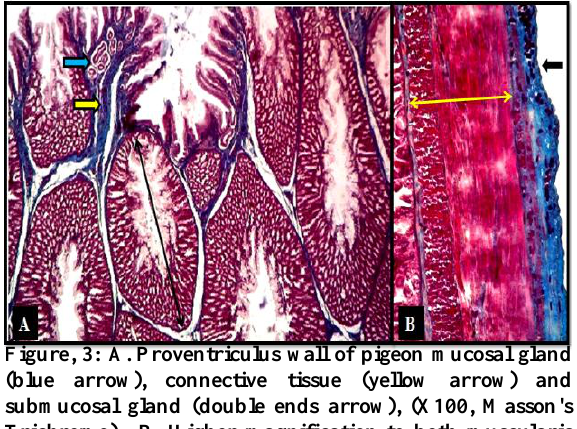
Figure, 3: A. Proventriculus wall of pigeon mucosal gland (blue arrow), connective tissue (yellow arrow) and submucosal gland (double ends arrow), (X100, Masson's Trichrome). B. Higher magnification to both muscularis (double ends arrow) and serosa (black arrow) layers, (X400).